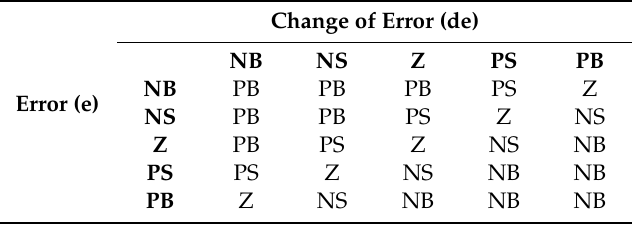
Table 3. Fuzzy rule table for the fuzzy ARX-Laguerre surgical robot for the sinus estimation algorithm.